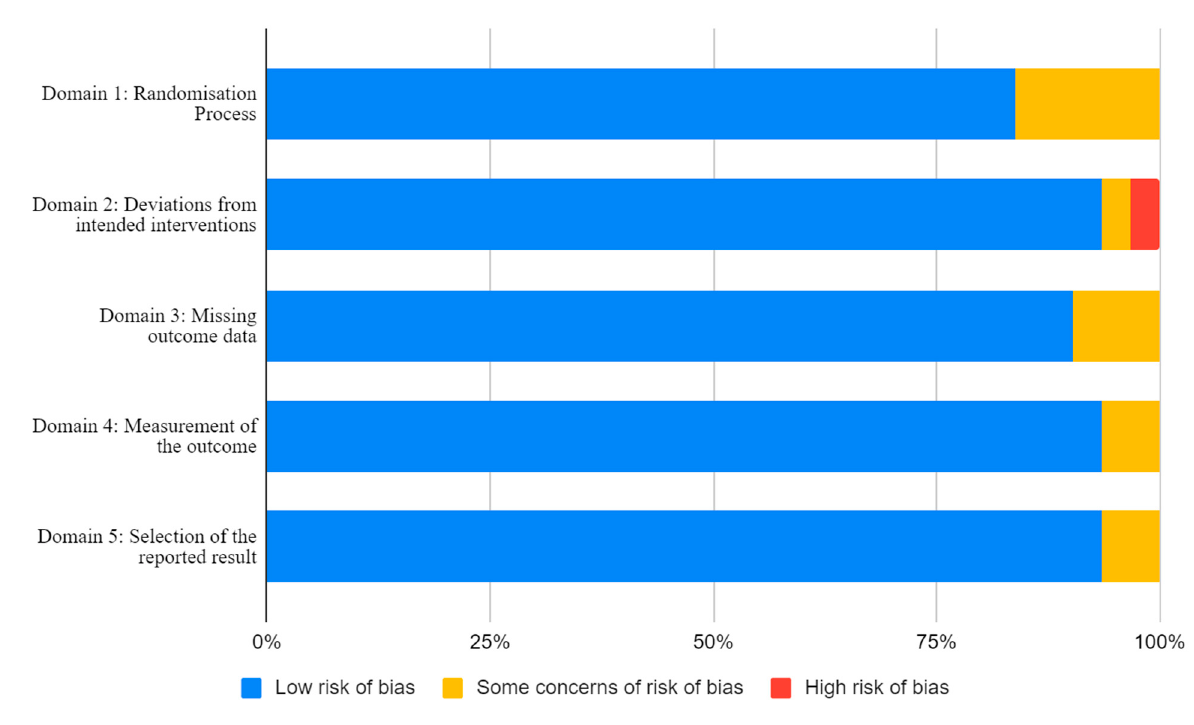
Table 2. Effect of whole grain consumption on inflammatory markers in healthy individuals be- tween the intervention and control diet.